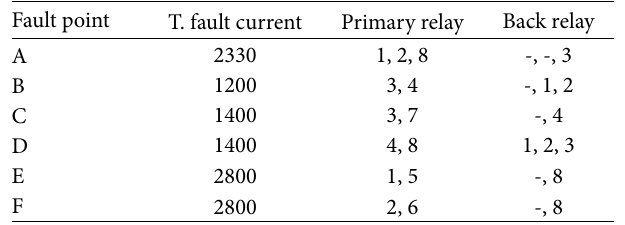
Figure 4: Comparison of the graphical representation of TMS with the CGA, FA, CFA, and CPSO and RTO algorithms for Case 1. Table 6: Comparison of the total net gain time achieved by the proposed method for Case 1.